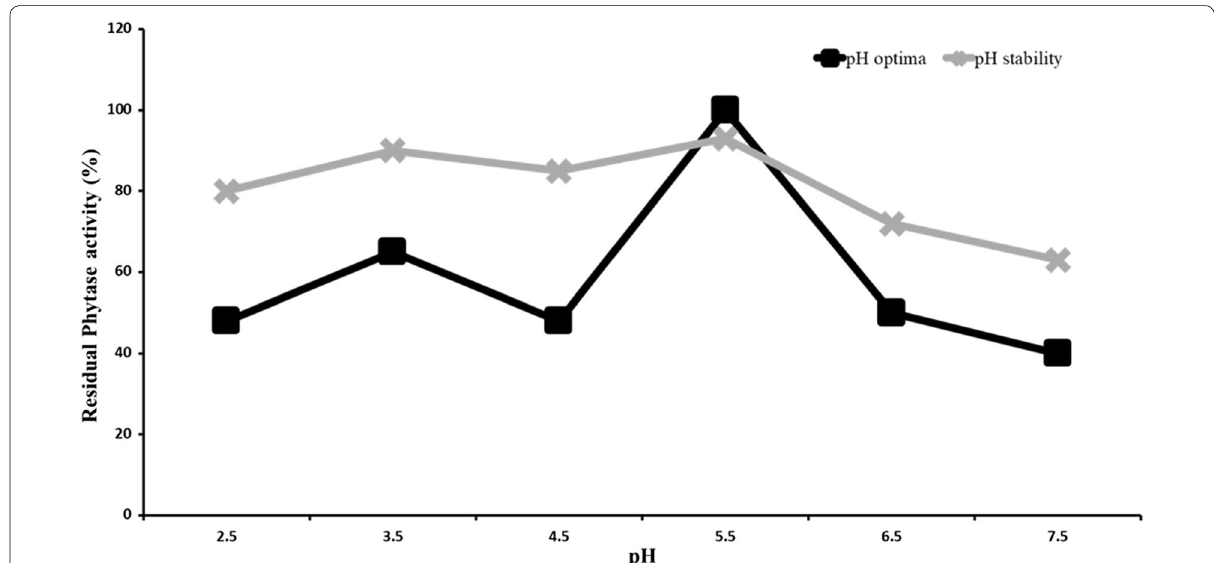
Fig. 3 pH profile of purified phytase from Aspergillus foetidus MTCC 11682 at incubation temperature of 37 °C. The pH optimum of 5.5 was observed and enzyme was found stable in acidic